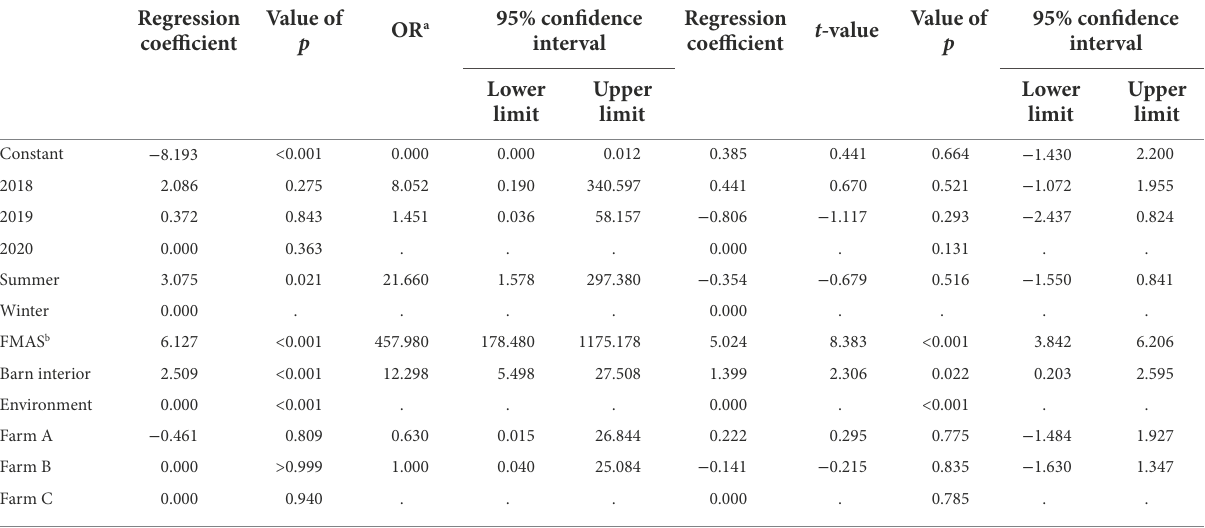
TABLE 4 Estimated regression coefficients, t and p values, Odds-Ratio and corresponding 95% confidence intervals (CI) of the mixed logistic and linear regression models. The random effect is visits within farm, the fixed effects are year, season, category and farm. Dependent variables are the probability for positive samples for the logistic and log 10 MPN/g for the linear model. Rows without OR or t -value represent the reference group. In this line, the variable’s global p values are